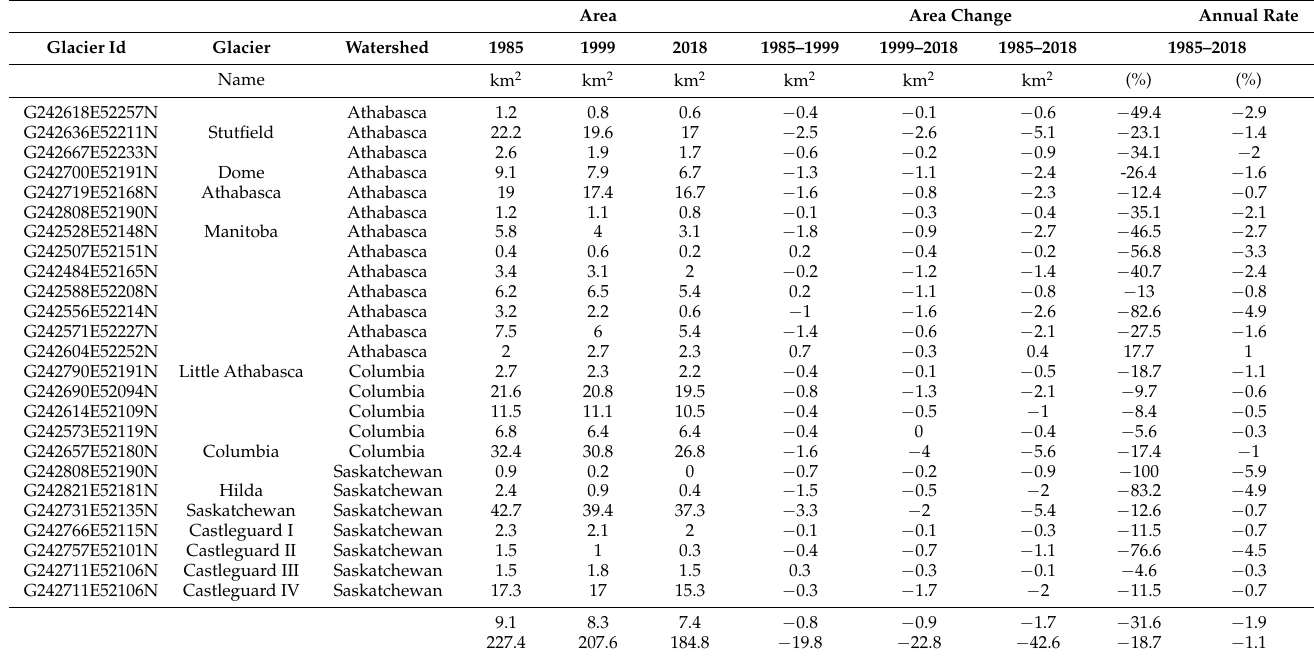
Table 3. Glacier area change between 1985 and 2018. Area Area Change Glacier Id